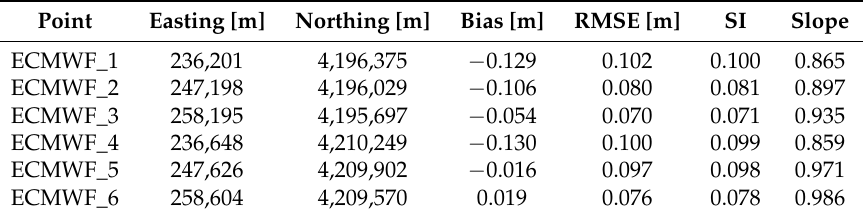
Table 2. Comparison of the ECMWF and model H m 0 values in the selected points of simulation domain (coordinates in ED50-UTM33N); particularly the indices are the bias, the root mean square error (RMSE), the Scatter Index (SI) and the regression line slope. Point Easting [m] Northing [m] Bias [m] RMSE [m] SI